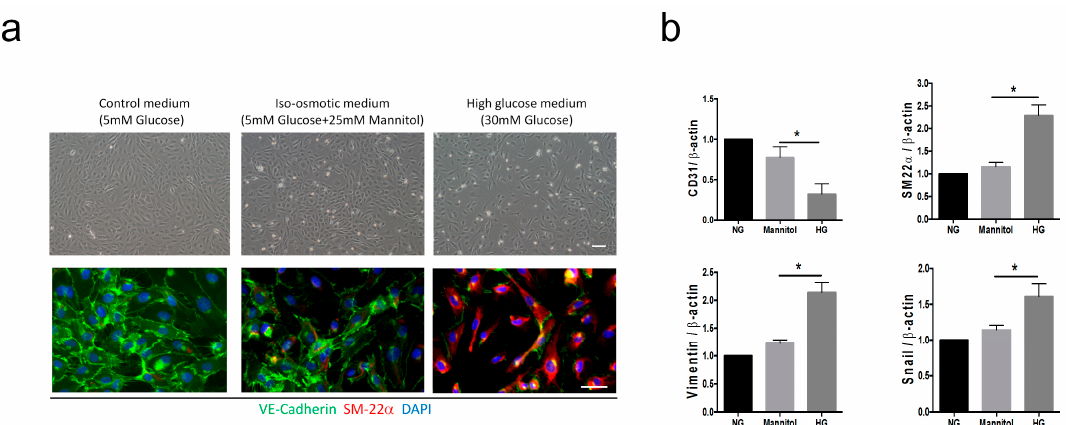
Figure 3. High glucose induces mesenchymal-like phenotypes in human umbilical venous endothelial cells (HUVECs). HUVECs were cultured in a control medium with a normal glucose level (NG, 5.5 mM of glucose), mannitol (M, 5.5 mM of glucose + 24.5 mM of mannitol), or high glucose (HG, 30 mM of glucose). ( a ) Representative bright-field images show the morphological changes in cells after 96 h of culture at different conditions. Scale bar represents 200 μ m. The expression of VE-cadherin (green) and SM22 α (red) in each group was analyzed using immunofluorescence staining. Nuclei were counterstained with DAPI (blue). HUVECs cultured in a HG medium showed a higher SM22 α expression and a lower VE-cadherin expression compared to those in NG- or mannitol-treated groups. Scale bar represents 50 μ m. ( b ) qRT-PCR analysis of the mRNA levels of CD31, SM22 α , vimentin, and Snail in NG-, mannitol-, and HG-treated HUVECs. Data are shown as the mean ± SD from three independent experiments. * P < 0.05. The statistical significance was assessed by Kruskal–Wallis test.